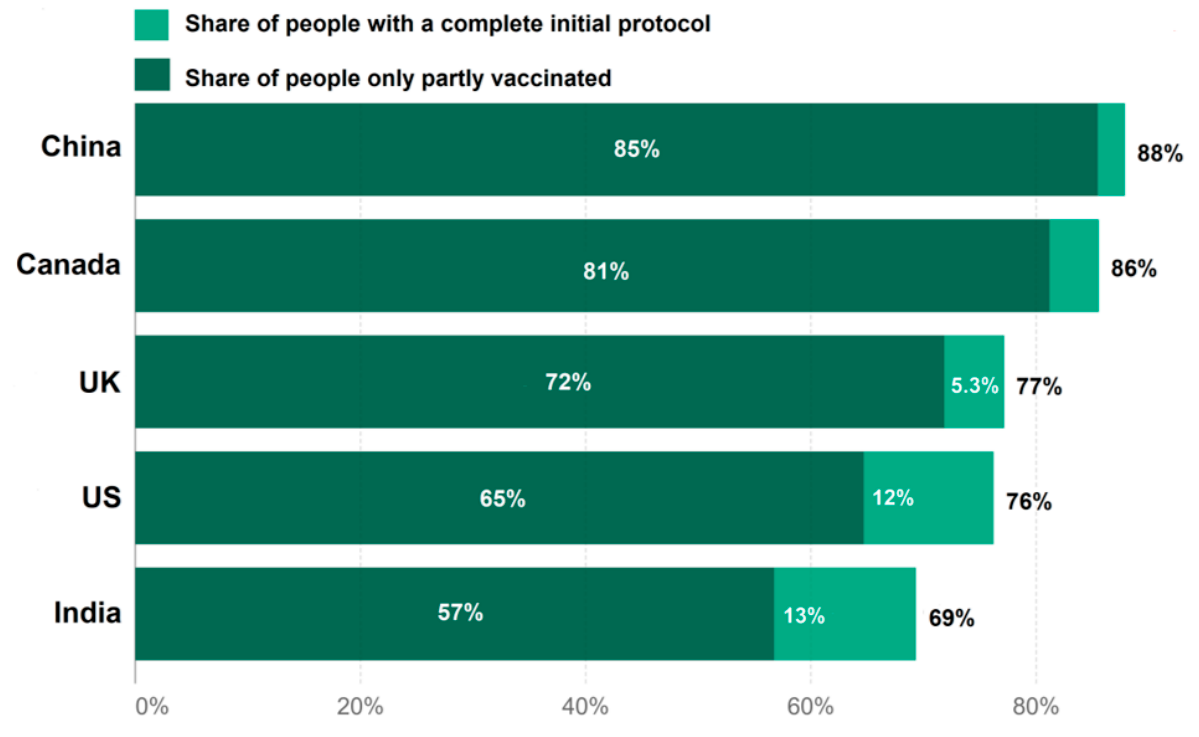
Figure 6. COVID-19 vaccine coverage in five countries. Table 4. The average of sentiments and number of tweets in the top five most posted countries.